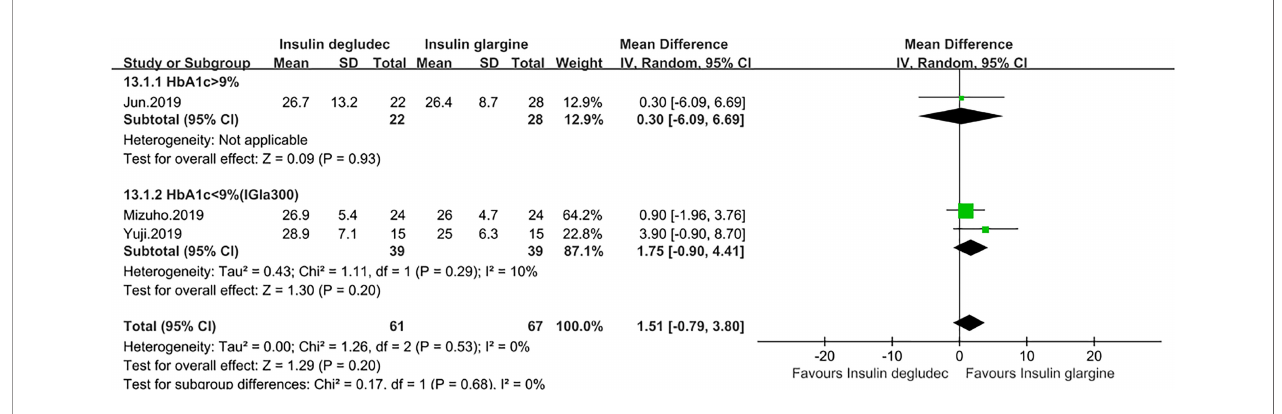
FIGURE 7 | Forest plot for the CV of 24 h in patients with type 2 diabetes.